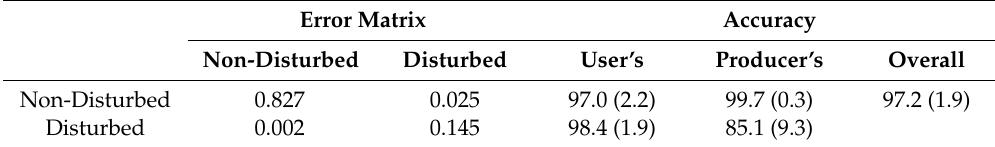
Table 2. Error matrix of estimated proportions of area for change detection assessment and accuracy estimates from independent validation of 725 pixels of the Minnesota disturbance map for the period 1974–2018. Accuracy uncertainty was calculated as 95% confidence intervals and is reported in parenthesis.